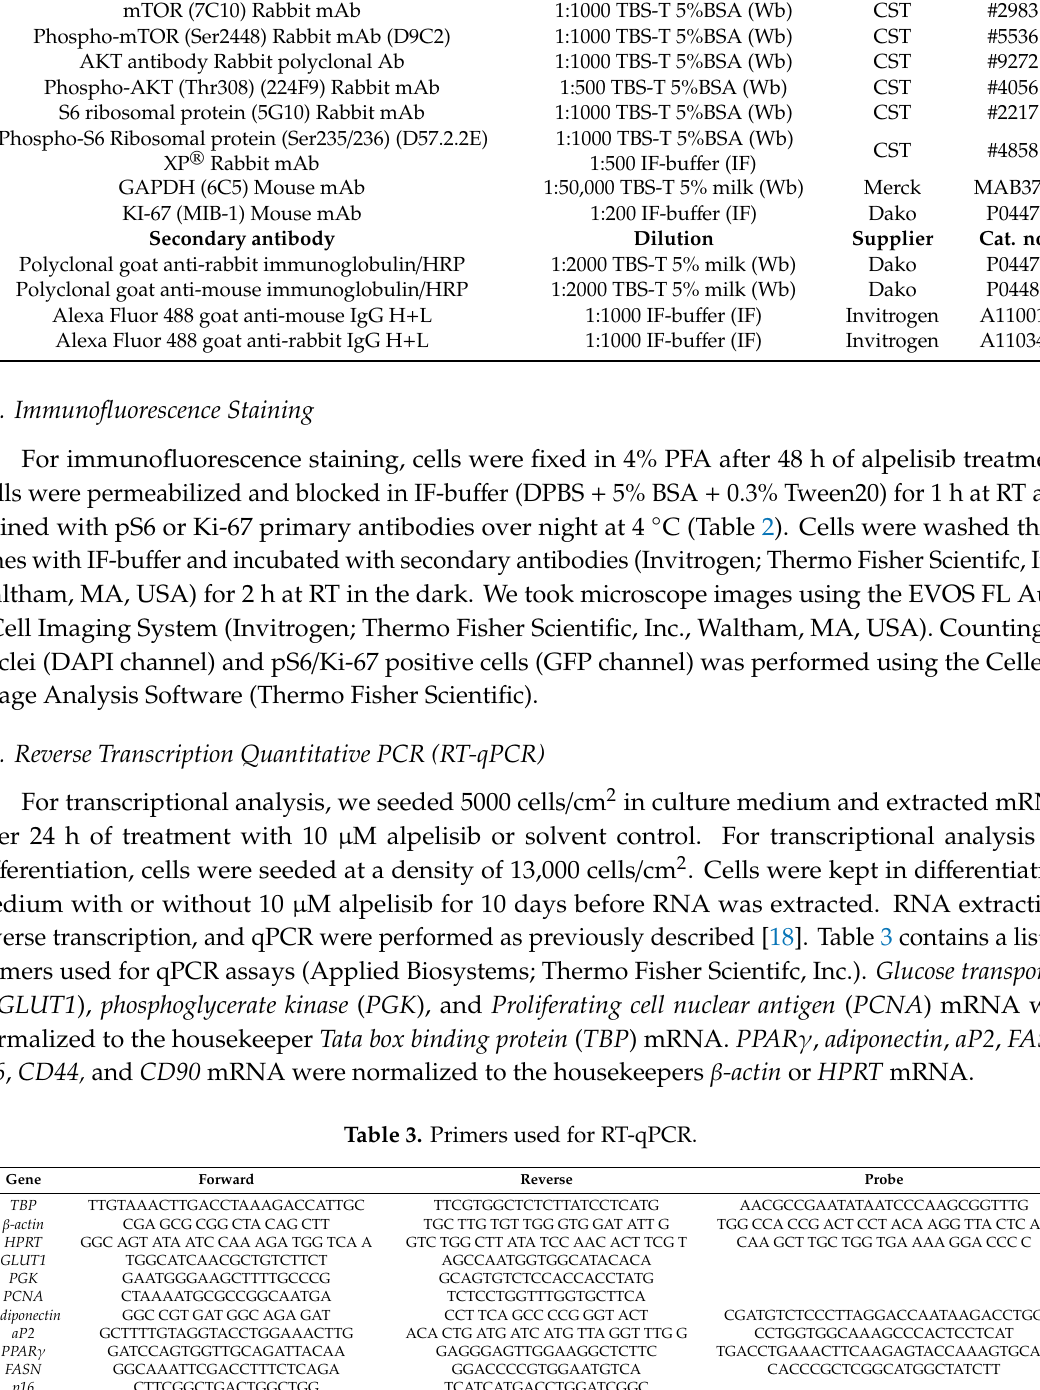
Table 2. Antibodies used for Western blot (Wb) and immunofluorescence staining (IF). Primary Antibody